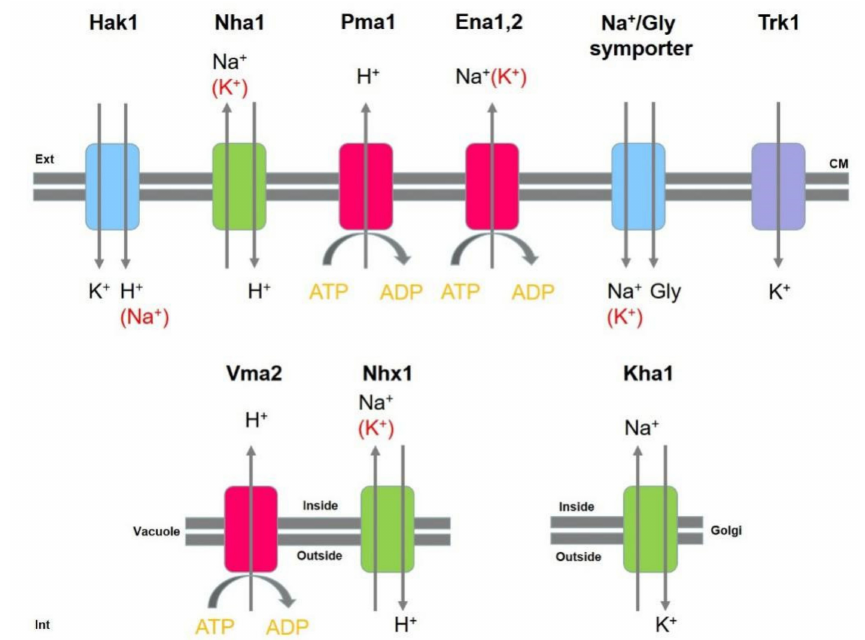
Figure 3. Osmoregulation in Debaryomyces hansenii . Main transport systems and pumps located in the cell membrane (CM), vacuole and Golgi apparatus, and involved in the maintenance of the intracellular osmolarity, are represented in the figure. ATP: adenosine triphosphate. ADP: adenosine